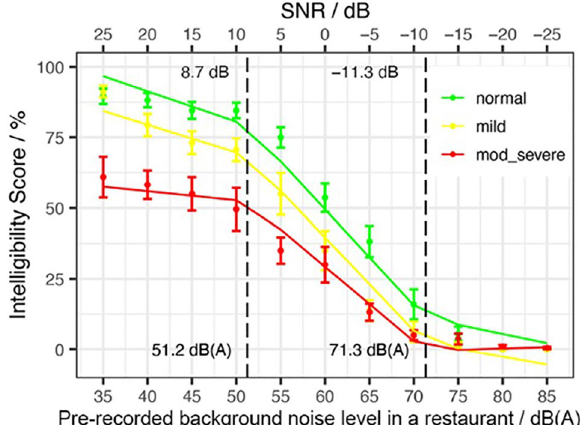
Figure 3. Intelligibility scores as function of SNR dB (labels on the top) and level of the pre-recorded background noise level in a restaurant in dB(A) (labels on the bottom). Vertical dashed lines mark the change-